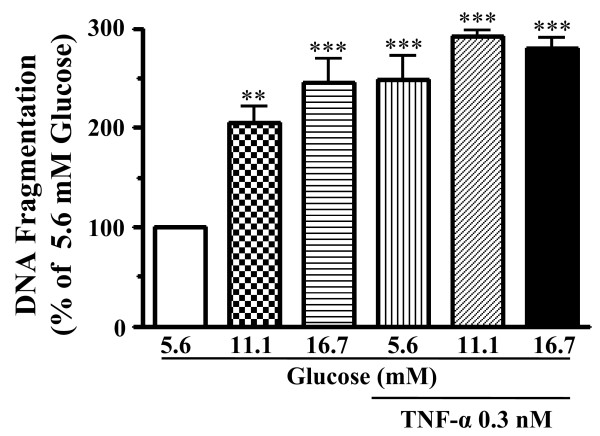
Abilities of high glucose (11.1 and 16.7 mM) and TNF-α (0.3 nM) to induce apoptosis in HCAECs. The DNA fragmentation was assayed as a biochemical hallmark of apoptosis. Values are expressed as mean ± SE (n = 3). **P < 0.01, ***P < 0.001 versus normal glucose (5.6 mM) without TNF-α.